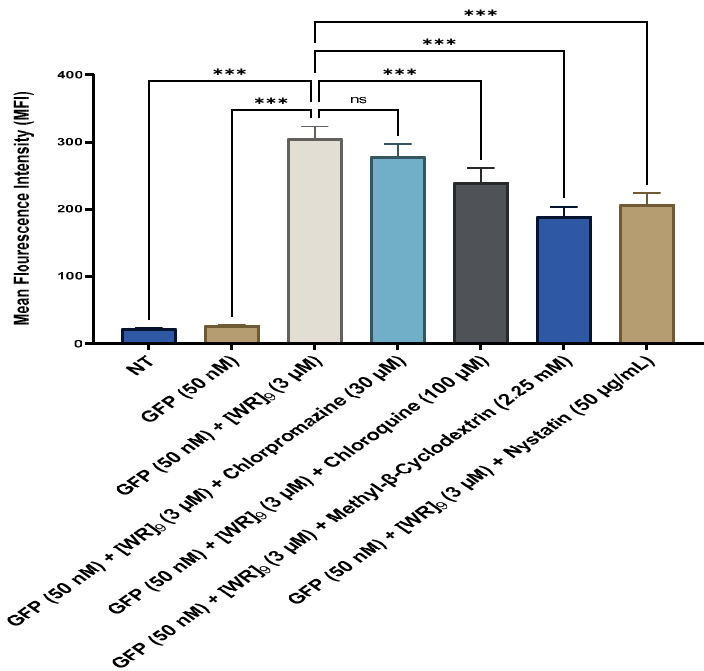
Figure 18. Cellular uptake of the GFP-[WR] 9 mixture at a peptide concentration (3 μ M) and GFP at (50 nM) for 3 h in MDA-MB-231 cells studied by flow cytometry. The results are mean ± SD ( n = 3) (ns; no significance, *** p < 0.001); treatments vs. control (GFP alone).